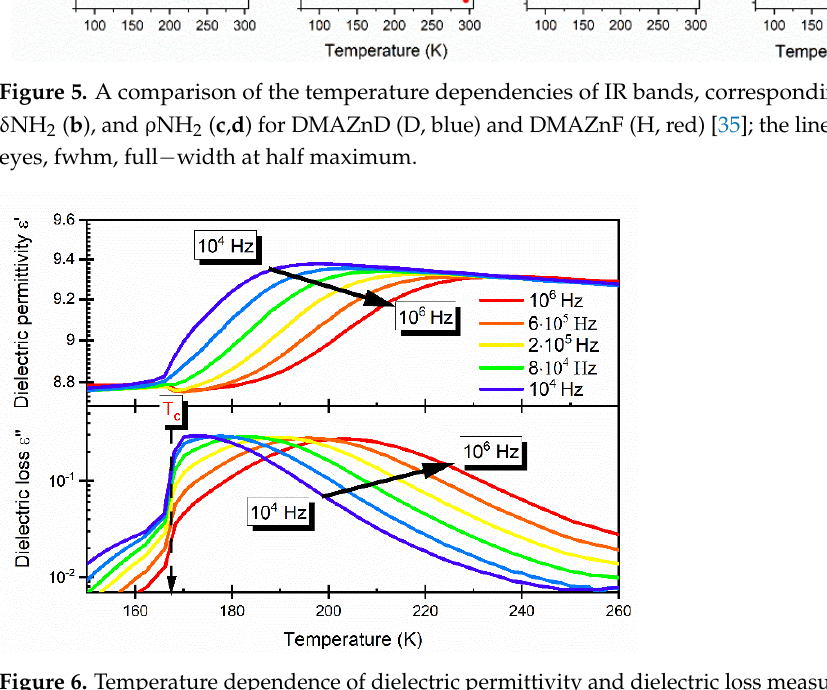
Figure 6. Temperature dependence of dielectric permittivity and dielectric loss measured for selected frequencies for DMAZnD.